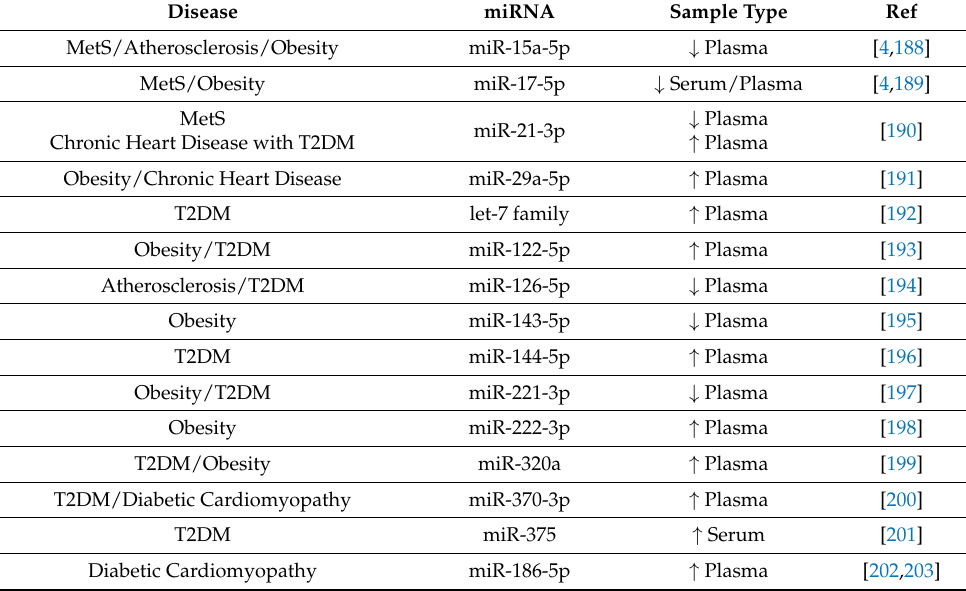
Table 3. Human studies reporting association between circulatory miRNAs and features of metabolic